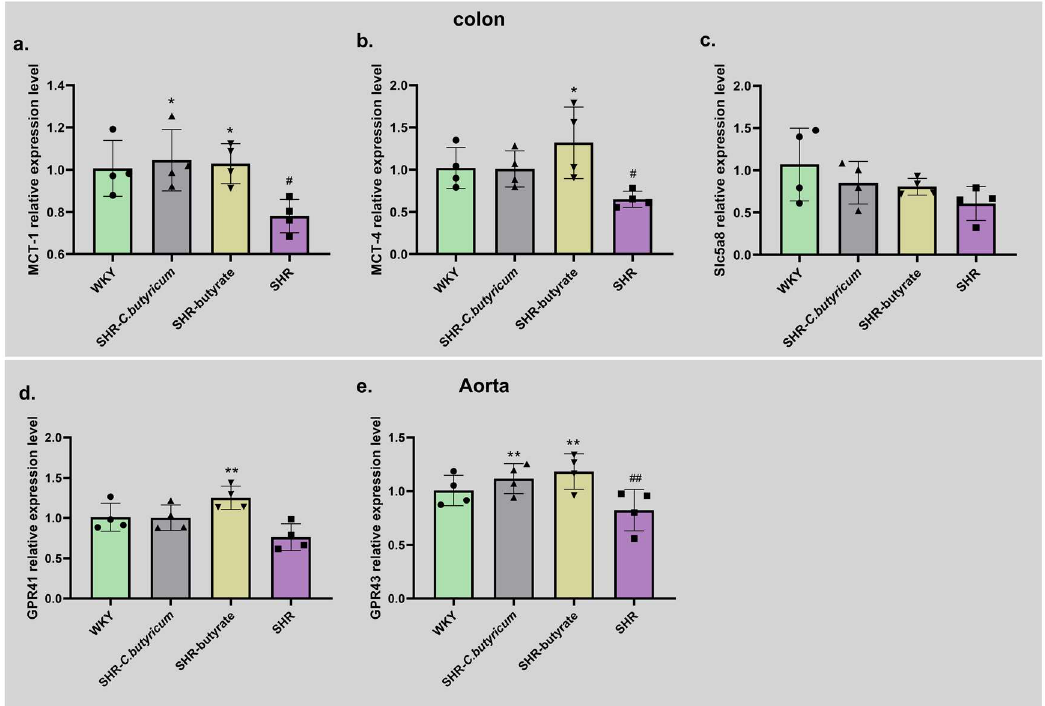
Figure 7. The relative expression levels of SCFAs transporters and SCFA-sensing receptors were altered by C. butyricum or butyrate. ( a – c ) C. butyricum or butyrate prevented the decrease in the relative expression of colonic SCFAs transporter proteins MCT1, MCT4, and Slc5a8 caused by SHR. ( d , e ) SHR significantly decreased the relative expression levels of the aortic SCFA-sensing receptors GPR41, GPR43 mRNA (GPR41, p = 0.055 for WKY vs. SHR; GPR43, p < 0.001 for WKY vs. SHR). The relative expression levels of GPR41 and GPR43 were significantly increased after treatment with C. butyricum or butyrate. Data are shown as the mean ± S.E.M., * p < 0.05, ** p < 0.01 for SHR